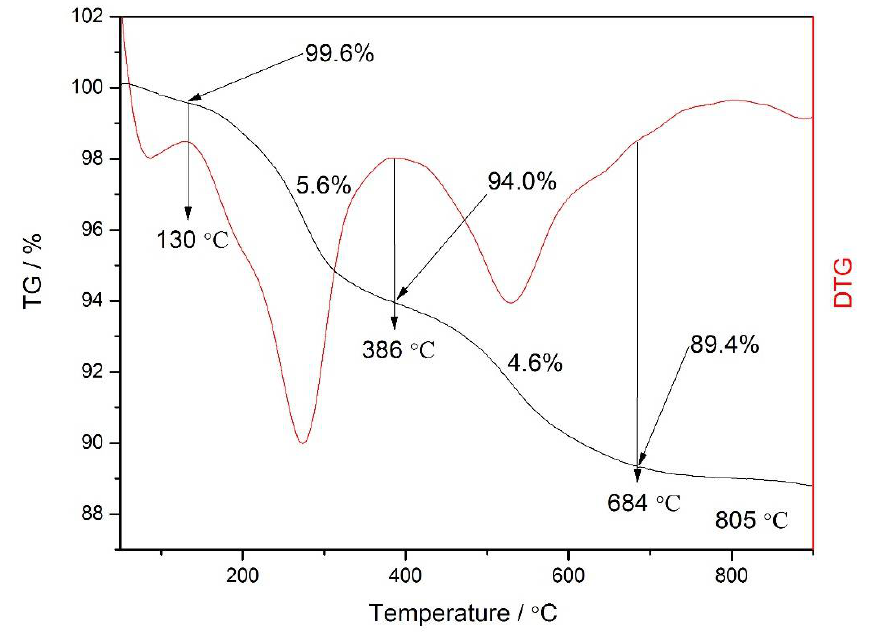
Figure 3. Thermogravimetric TG and derivative weight loss (DTG) curves of Eu@MCM-41-P (IL-AA).